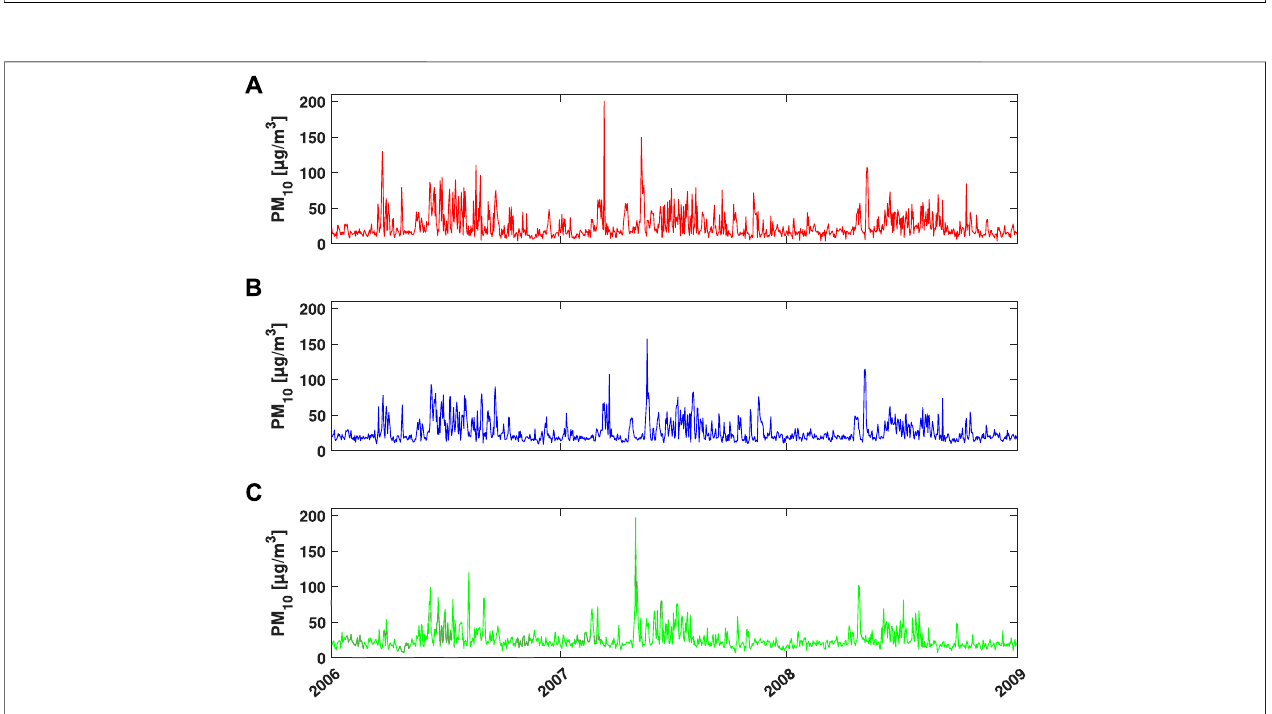
FIGURE 2 | Illustration of daily measurements sequences of PM 10 times series in (A) Martinique (MAR), (B) Guadeloupe (GPE) and (C) Puerto-Rico (PR) between 2006 and 2009.